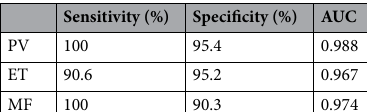
Table 1. Performance of the DLS-based diagnostic system in MPN